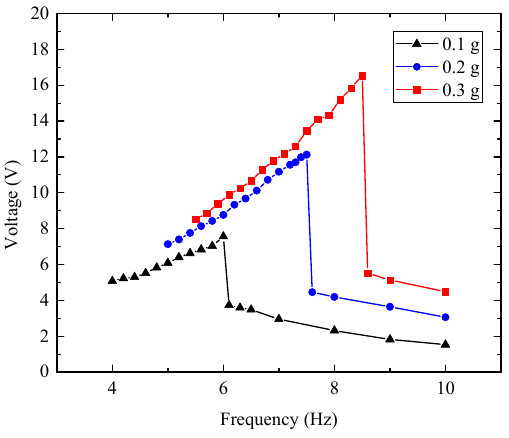
Figure 13. RMS voltage versus excitation frequency.